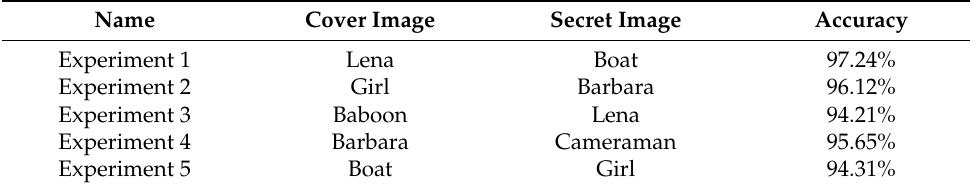
Table 5. Comparison of Experiments Based on